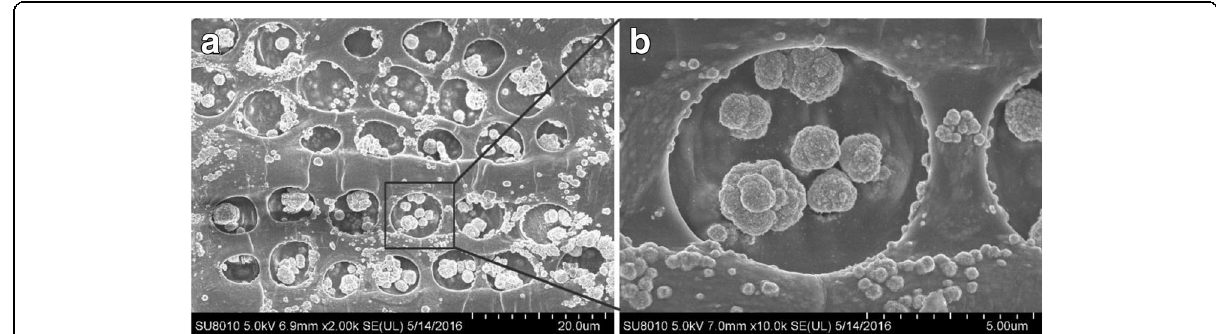
Fig. 7 FE-SEM observations of Cu NPs in pits of wood (group F). a 2k magnification, b 10k